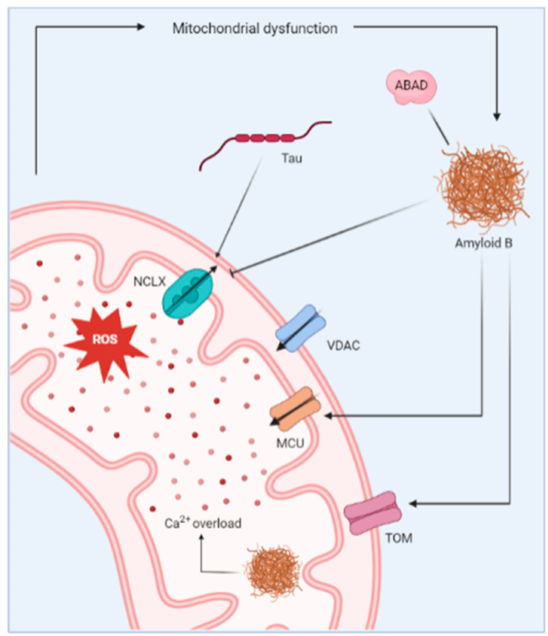
Figure 4. Representation of the mitochondrial changes reported in Alzheimer’s disease. A β has been shown to induce mitochondrial Ca 2+ overload via different mechanisms. For instance, A β inhibits Ca 2+ extrusion by blocking the Na + /Ca 2+ exchanger (NCLX). On the other hand, A β promotes Ca 2+ uptake via interaction with mitochondrial Ca 2+ uniporter (MCU). A β deposits are also detected inside the mitochondria where they further contribute to dysregulated Ca 2+ homeostasis. The uptake of A β in the mitochondria is reportedly regulated by translocase of the outer membrane (TOM) machinery. The mitochondrial Ca 2+ overload causes increased production of ROS and further leads to mitochondrial